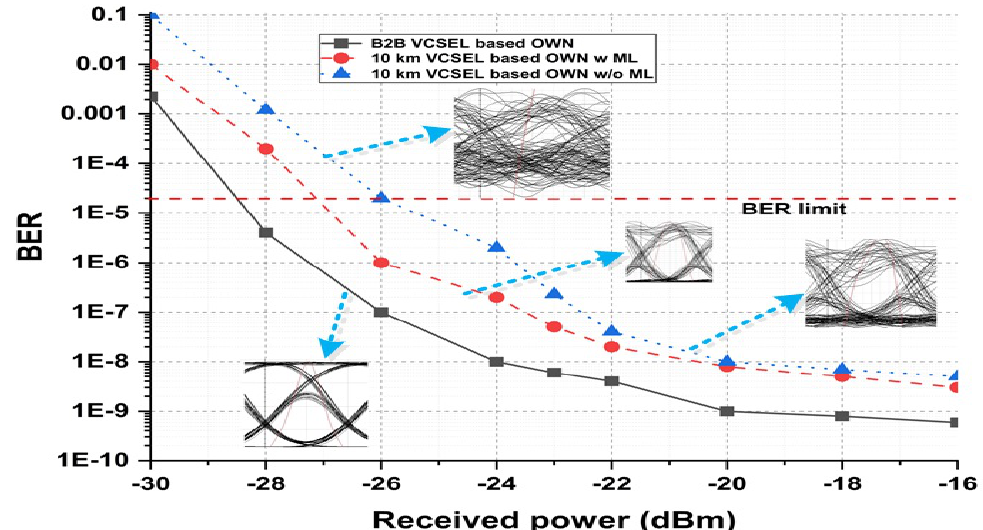
Figure 4. ML-based VCSEL OWN achievements in terms of BER against output power, estimating B2B VCSEL-based OWN, VCSEL-based OWN at 10 km using ML, and traditional VCSEL-based OWN at 10 km.